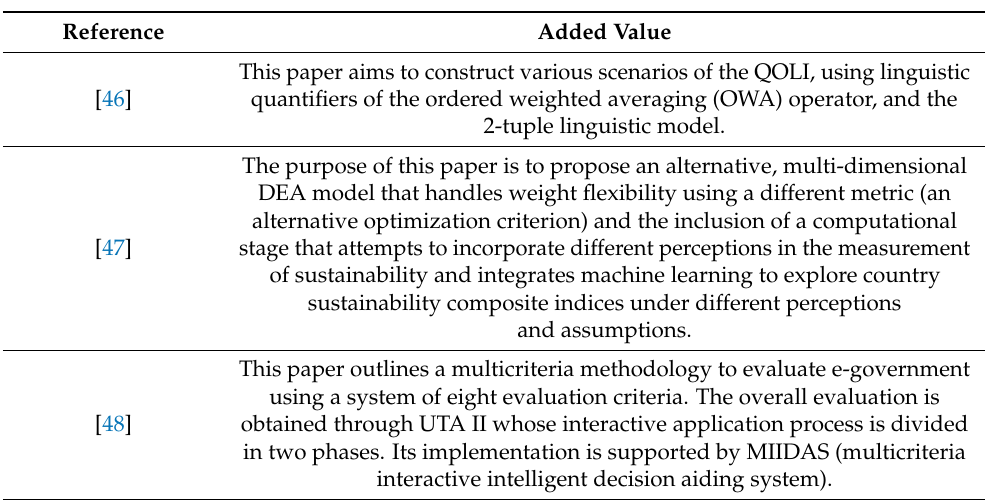
Table 3. Literature review on papers using MCDM and computational intelligence to build composite